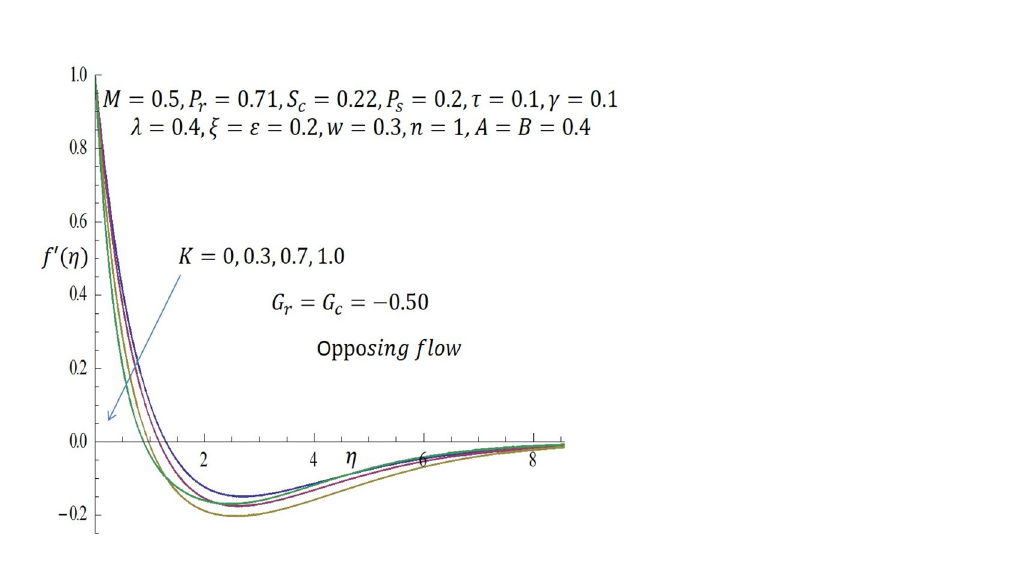
Figure 4. Effect of K on velocity profile when G r = G c = − 0.5